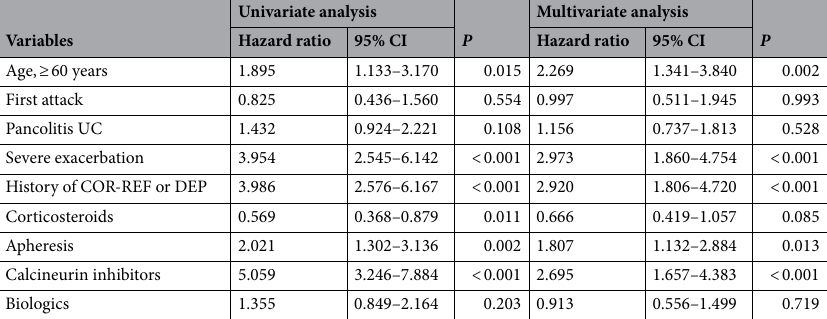
Table 3. Cox regression analysis of the factors for cumulative risk of surgical resection in patients with moderate to severe UC exacerbations.